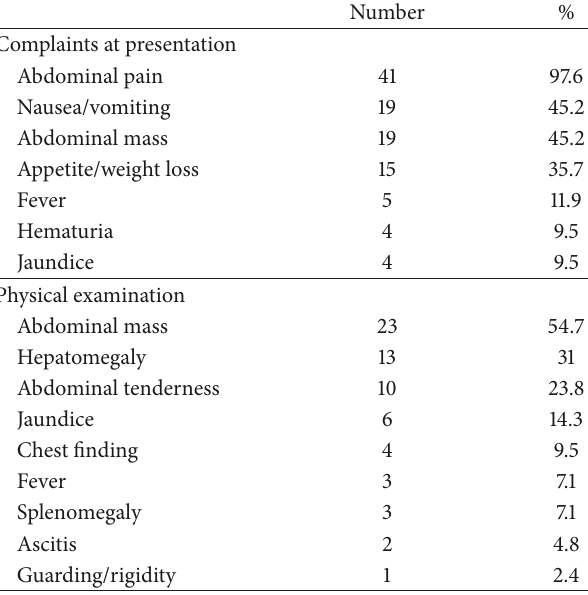
Table 2: Clinical findings of patients operated on for IAHC, SPHMMC,